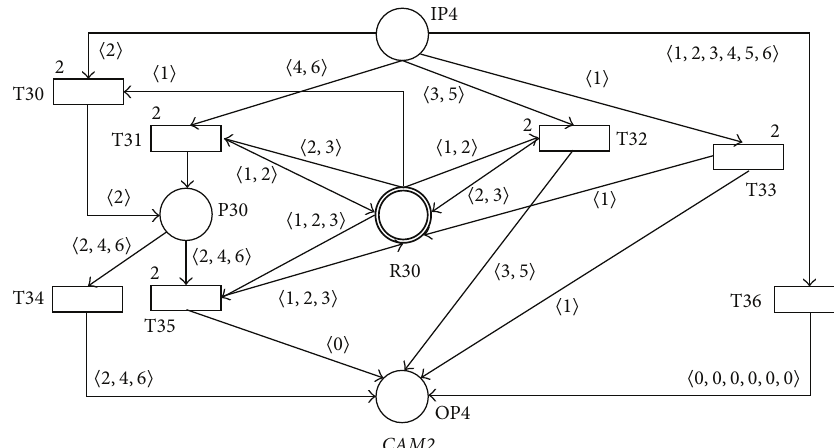
Figure 16: SNT process net RNET1.